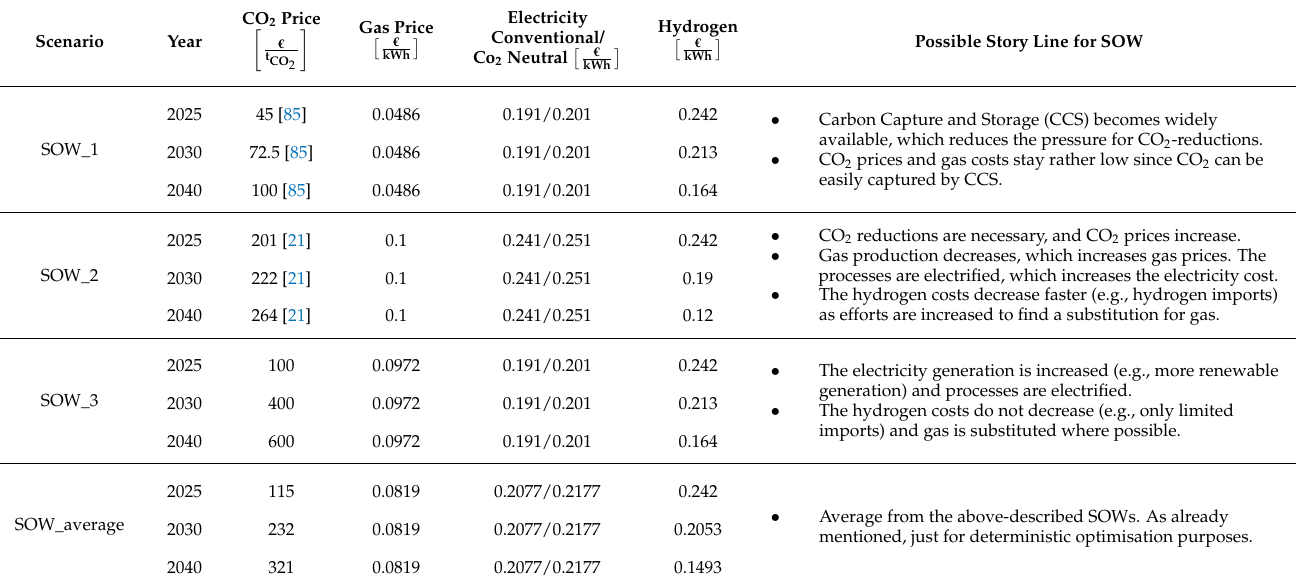
Table 4. Assumptions for uncertain CO 2 prices as well as energy carrier